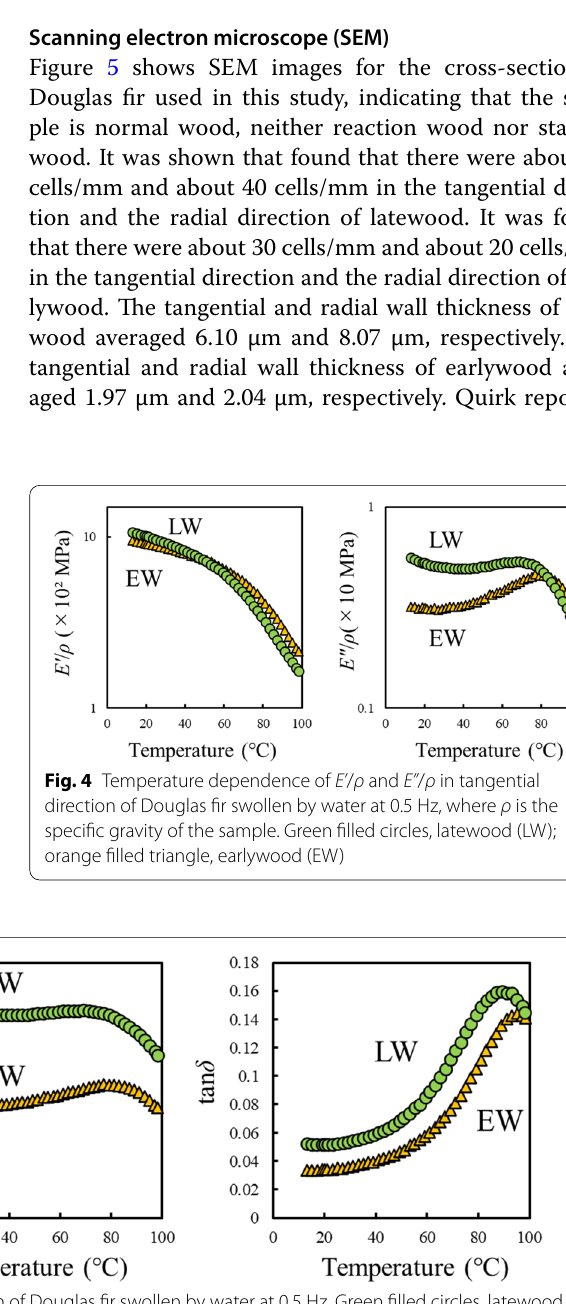
Fig. 3 Temperature dependence of E’ , E’’ and tan δ in tangential direction of Douglas fir swollen by water at 0.5 Hz. Green filled circles, latewood (LW); orange filled triangle earlywood (EW)